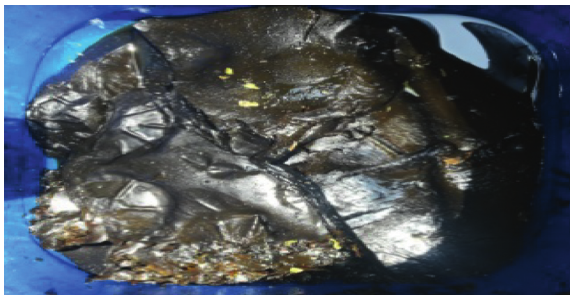
Figure 1: Sludge deposited in the oil tank of